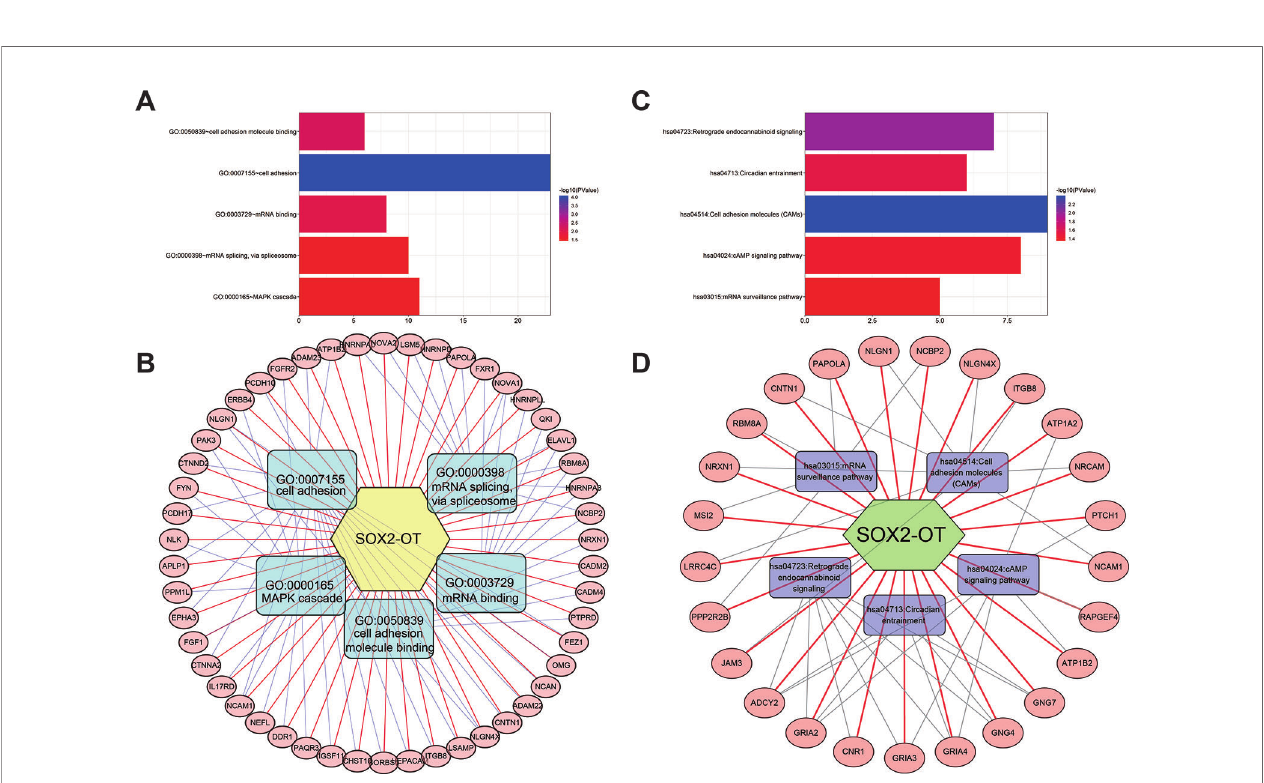
FIGURE 7 | Signi fi cantly enriched gene ontology (GO) categories and Kyoto Encyclopedia of Genes and Genomes (KEGG) pathways of potential targets of long non-coding RNAs (lncRNA) SOX2 overlapping transcript (SOX2-OT) in cancer patients. (A) biological processes (BP), (B) the lncRNA SOX2-OT-GO-mRNA network was generated based on the Multi Experiment Matrix (MEM) and DAVID databases. (C) KEGG pathway. (D) the lncRNA SOX2-OT-KEGG-mRNA network was generated based on the MEM and DAVID